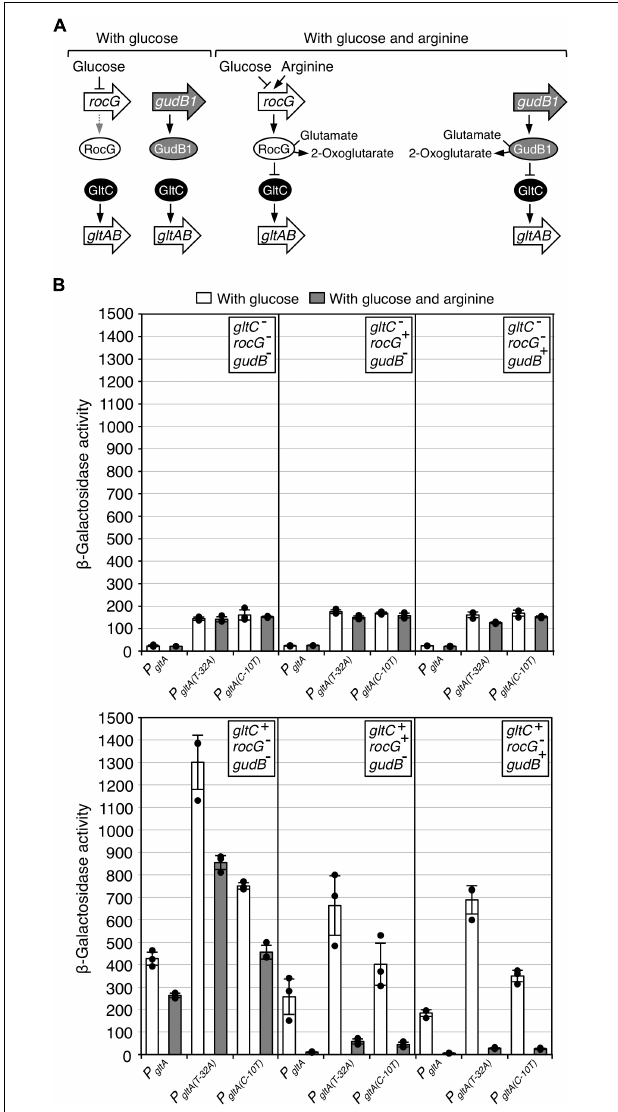
FIGURE 7 | (A) Control of DNA-binding activity of GltC by RocG and GudB1. (B) Regulation of the P gltA wild type and the partially constitutively active P gltA ( T − 32 A ) and P gltA ( C − 10 T ) promoters by GltC, and the GDHs RocG and GudB1. The strains BP812 ( P gltA -lacZ gltC − rocG − gudB − ), BP813